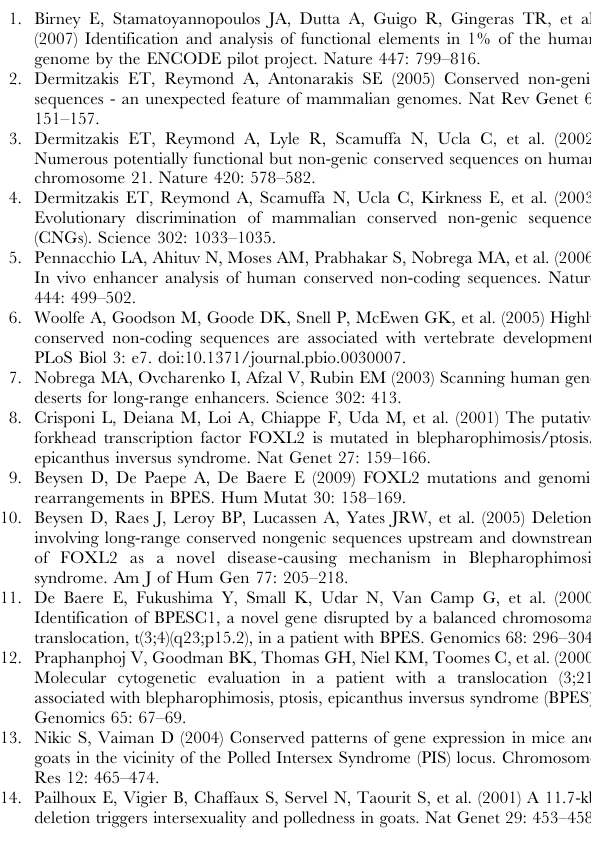
Table S2 Reported extragenic deletions in human genetic